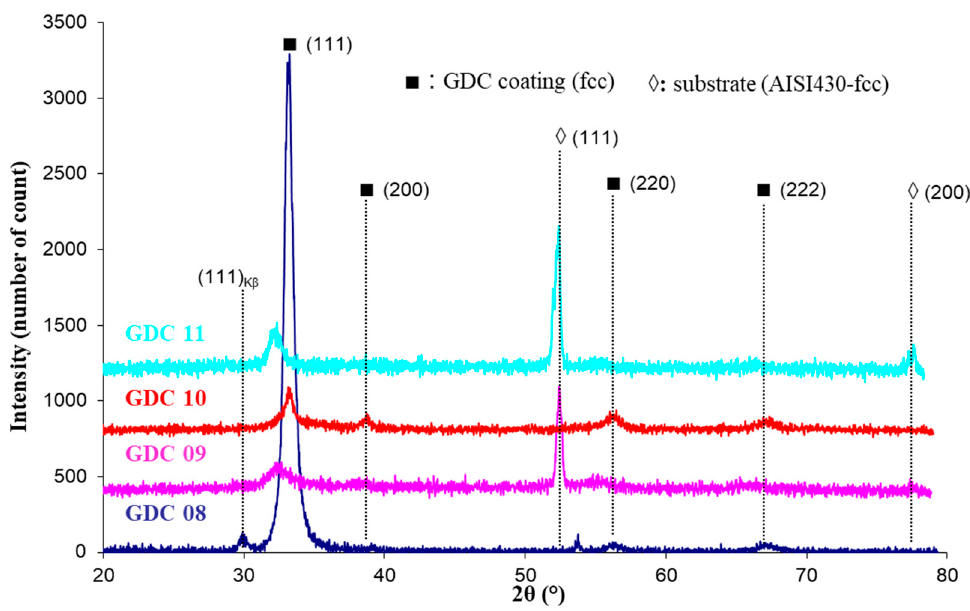
Figure 3. Grazing incidence X-ray diffractogram of GDC coatings deposited on AISI 430 stainless steel substrates.